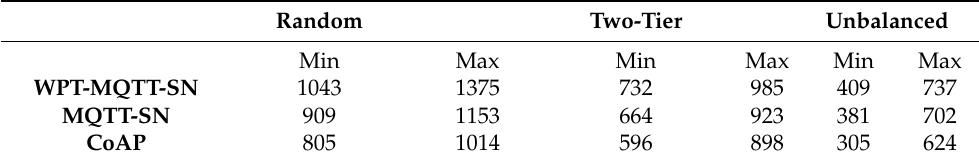
Table 4. Overall network lifetime comparisons for different topologies and protocols. Random